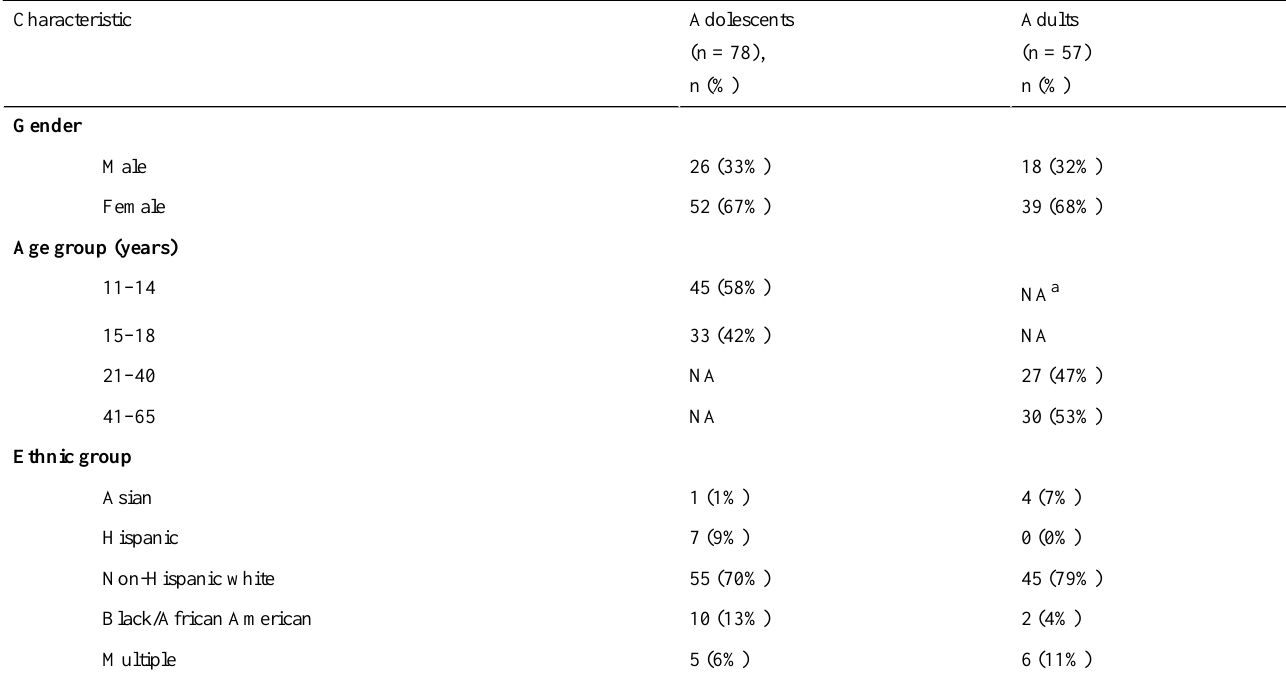
Table 1. Characteristics of adults and adolescents testing the usability of the mobile telephone food